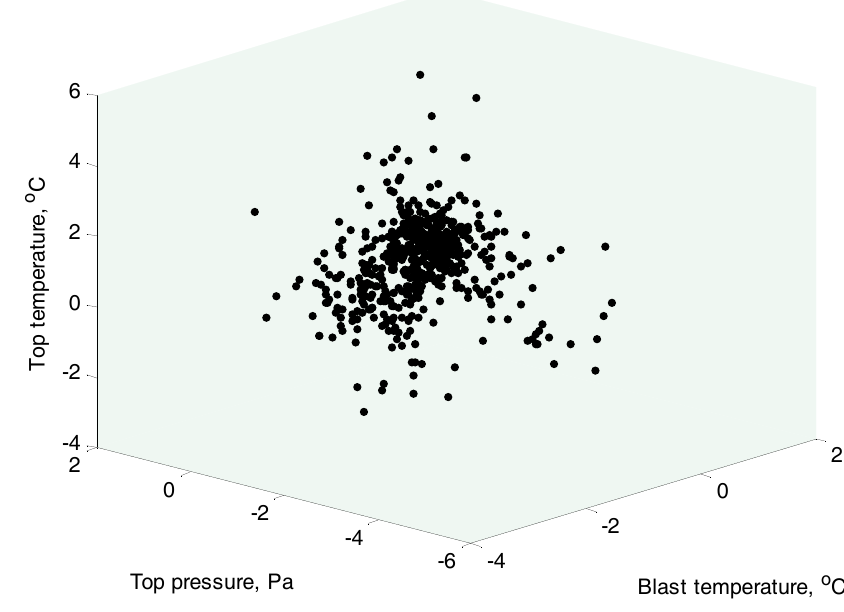
Figure 3. The spatial relationship of several process input variables in the training set.